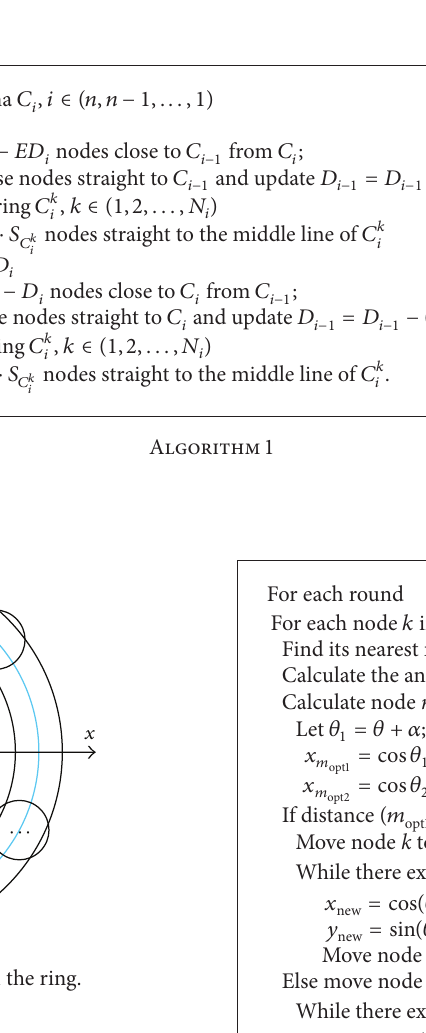
Figure 1: Optimal sensor redeployment with different equivalent sensing radii 𝑅 𝑖 . (a) 𝑅 𝑖 = 𝑅 𝑐 /2 : uniform distribution in single ring; (b) /2𝑅 ⌉ = 2 : uniform sensor distribution in two rings. ⌈𝑅 𝑐 𝑖